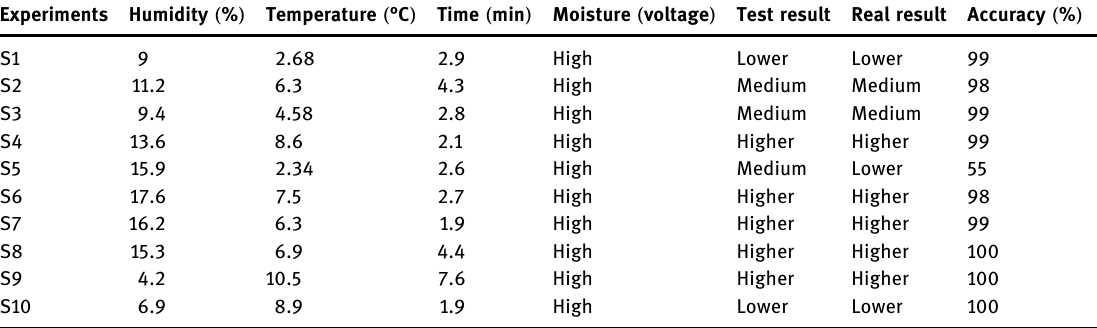
Table 6: ICWAS outcomes for ten experiments